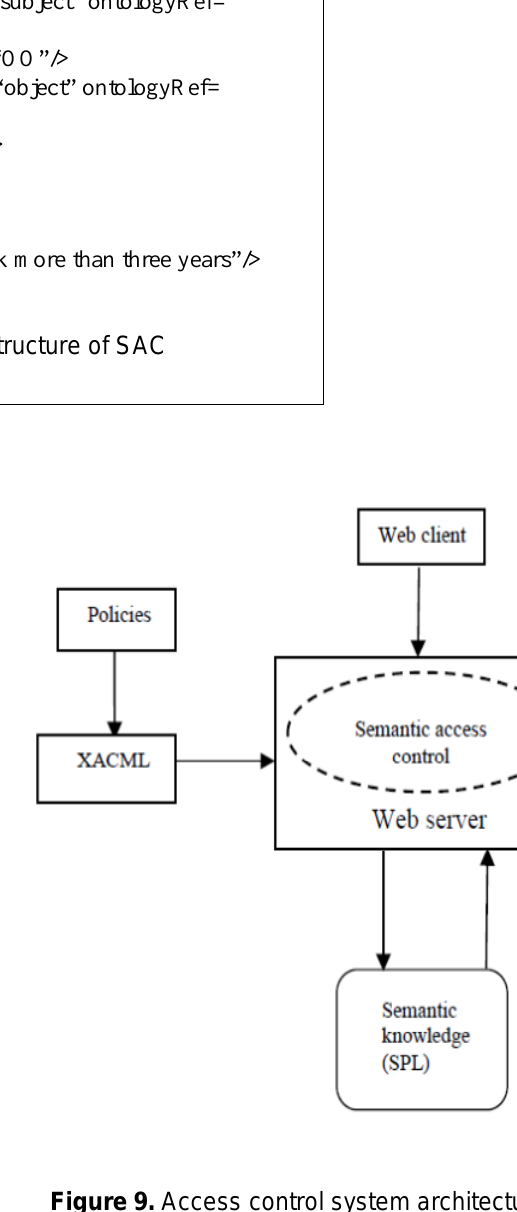
Figure 9. Access control system architecture